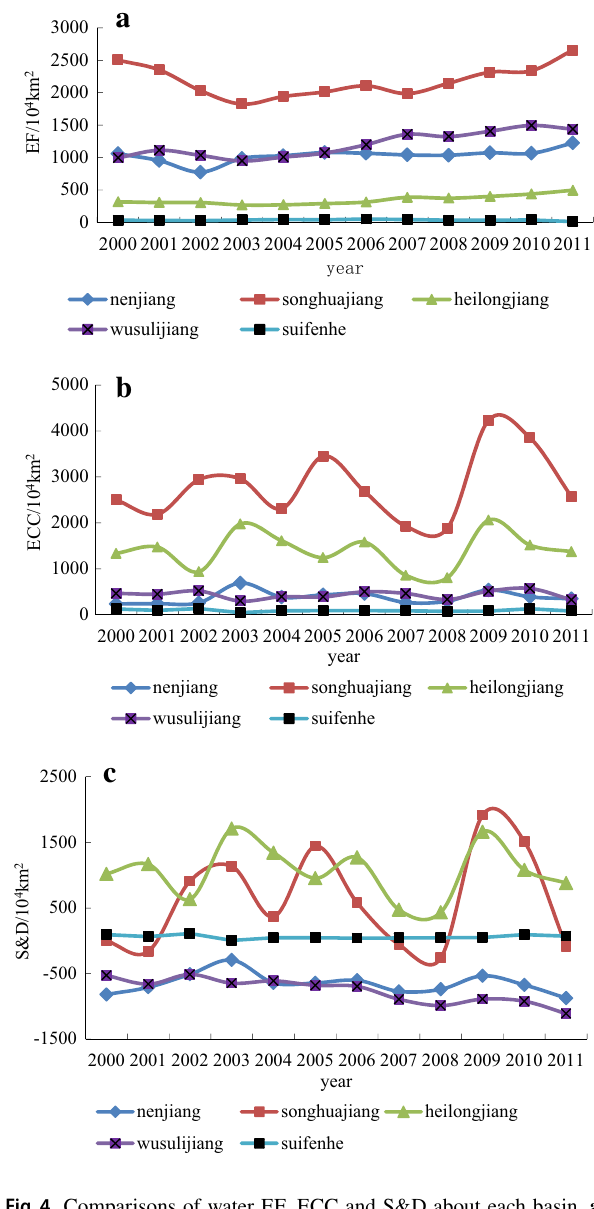
Fig. 4 Comparisons of water EF, ECC and S&D about each basin. a The water EF of each basin, b the water ECC of each basin, c the water S&D of each